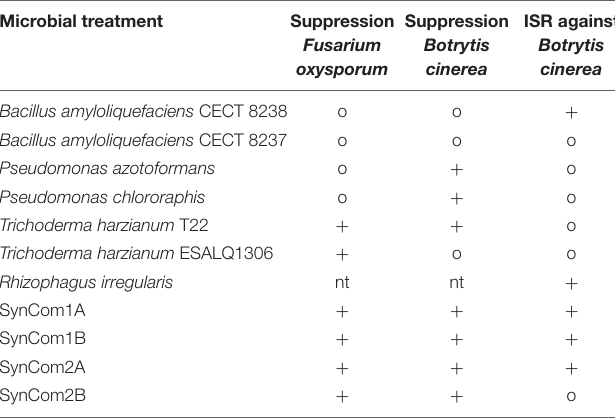
TABLE 1 | Effects of the microbial treatments tested in the different in planta bioassays. Microbial treatment Suppression